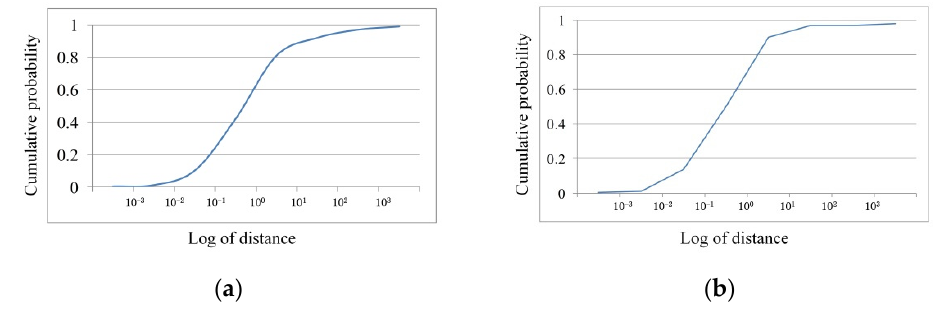
Figure 3. CDF of Dis between next Check-ins POIs: ( a ) CDF on Foursquare; ( b ) CDF on Yelp.